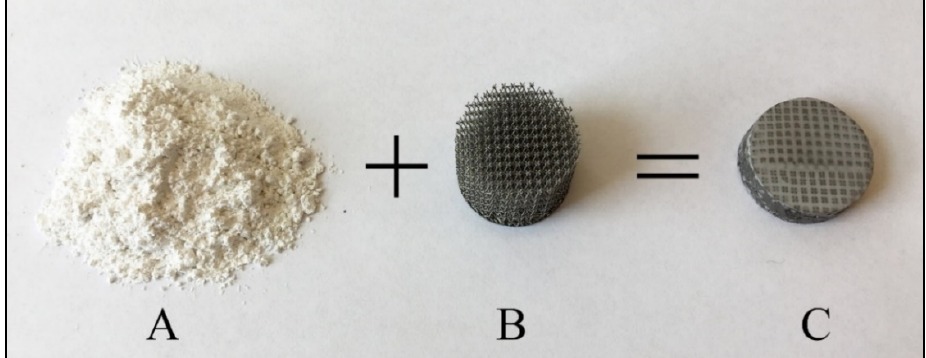
Figure 8. ( A ) Wollastonite (CaSiO 3 ) powder, ( B ) selective laser melting (SLM)-produced Ti6Al4V lattice structure with 1 mm cell size, and ( C ) Sintered sample (dimensions of lattice structure: 20 mm diameter and 15 mm height before spark plasma sintering (SPS) and 6 mm height after SPS and polishing).